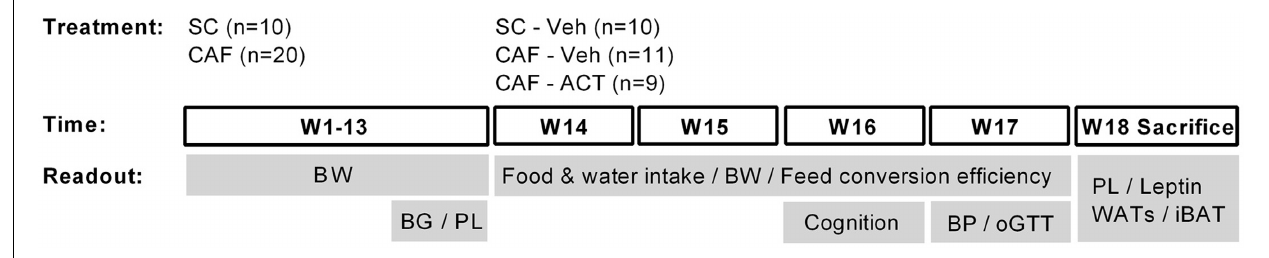
FIGURE 1 | Schematic overview of the experimental setup. Rats were maintained on standard chow (SC; n = 10) or cafeteria diet (CAF; n = 20) for 13 weeks (W). The CAF diet was comprised of a free choice between SC and a high fat/sweet diet, both provided at libitum, and intermittent additional access to human snacks. During these 13 weeks body weight (BW) was measured weekly and blood glucose (BG) and plasma lipid (PL) concentrations were assessed in week 11 and 13, respectively. Chronic vehicle (Veh) or ACT-335827 treatment (ACT; 300mg/kg, p.o., once daily before onset of the dark phase) started in week 14. All SC fed rats received vehicle treatment only (SC-Veh; n = 10). The CAF diet fed rats were divided into a vehicle (CAF-Veh; n = 11) and